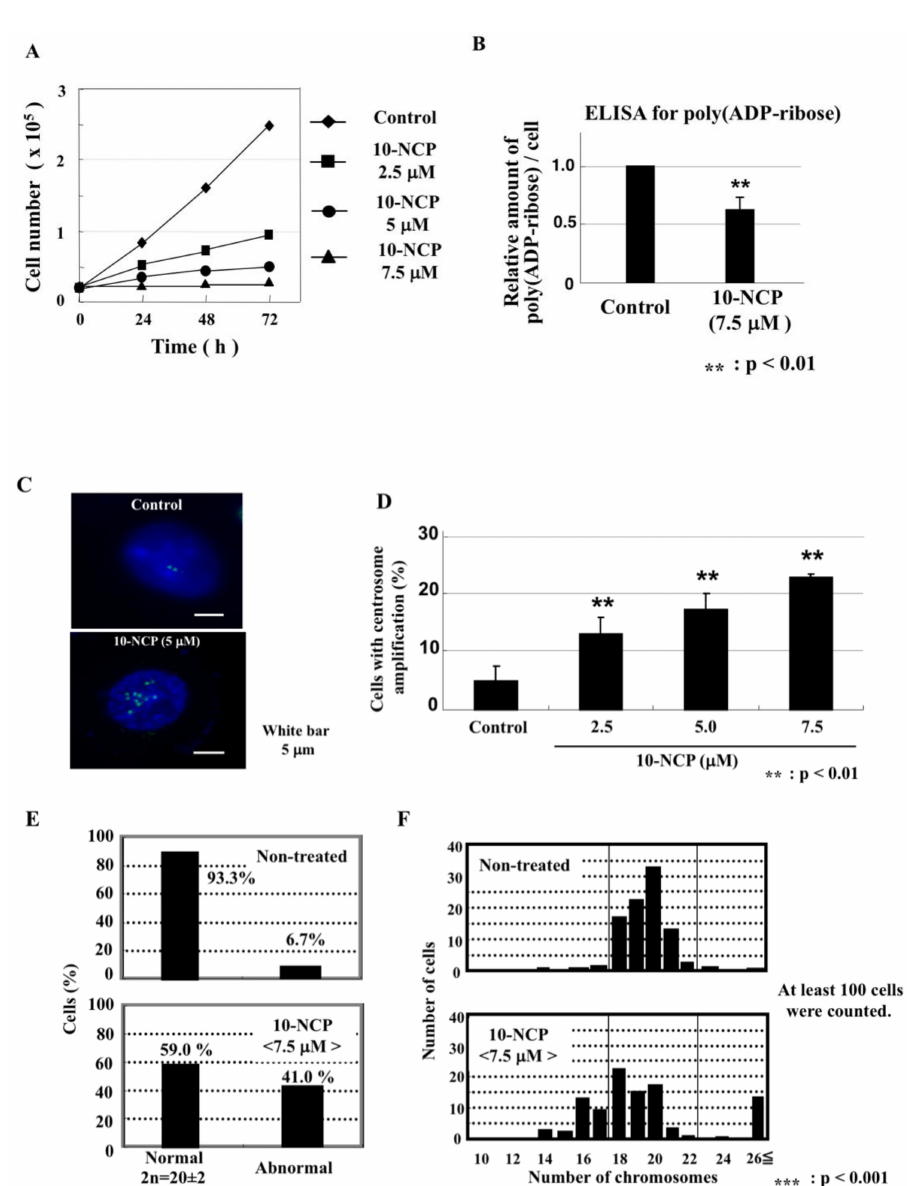
Figure 5. An Akt inhibitor, 10-NCP, inhibited in vivo polyADP-ribosylation and induced centrosome amplification and aneuploidy of chromosomes. ( A ) Inhibition of cell proliferation with indicated concentrations of 10-NCP. ( B ) Relative in vivo level of poly(ADP-ribose) per cell after culturing cells with 10-NCP for 48 h, determined by ELISA. ( C ) Cells were cultured for 48 h with or without 5 µ M 10-NCP and immunostained with an antibody against γ -tubulin. ( D ) Percentage of cells with centrosome amplification. Significance was assessed against the control. ** p < 0.01. ( E ) Cells with the number of chromosomes outside of the range of 20 ± 2 were defined as abnormal. Significance was analyzed with Fisher’s exact test. ( F ) Histogram of cells with a defined number of chromosomes. At least 100 metaphases were analyzed. Significance was analyzed with Fisher’s exact test against the control. *** p <